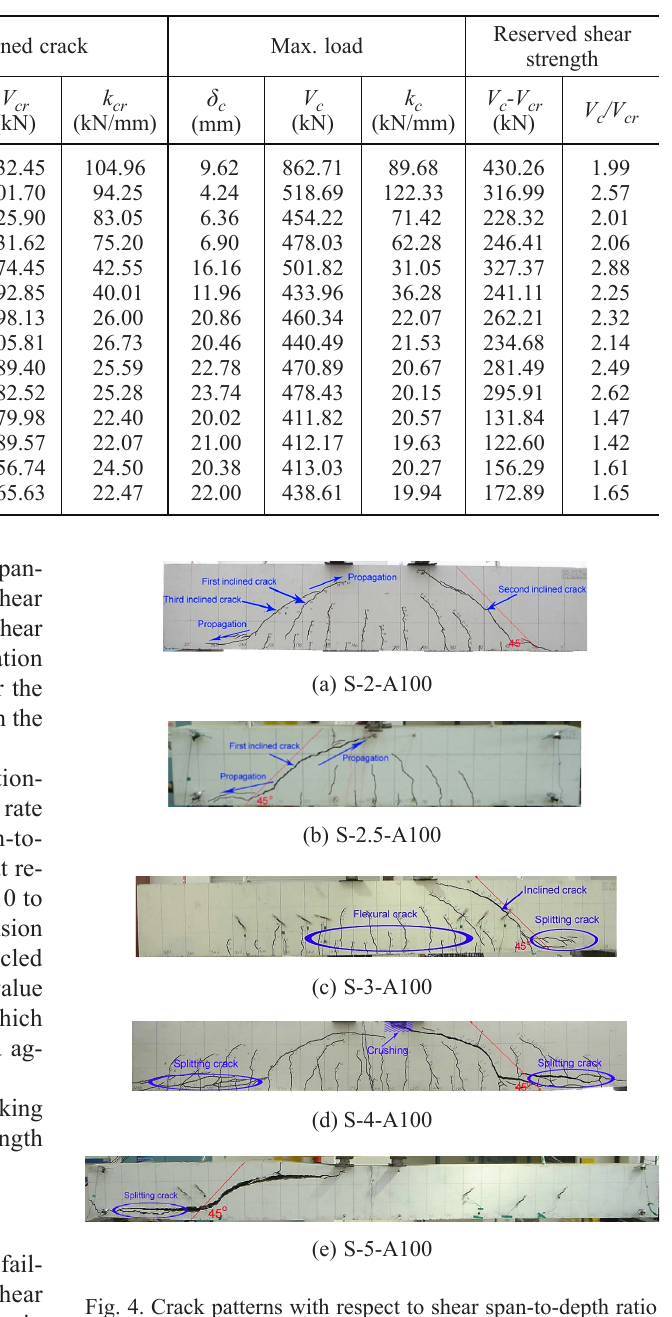
Fig. 4. Crack patterns with respect to shear